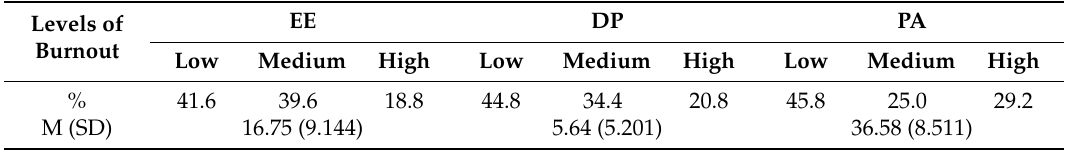
Table 2. Levels of burnout in each of its dimensions.